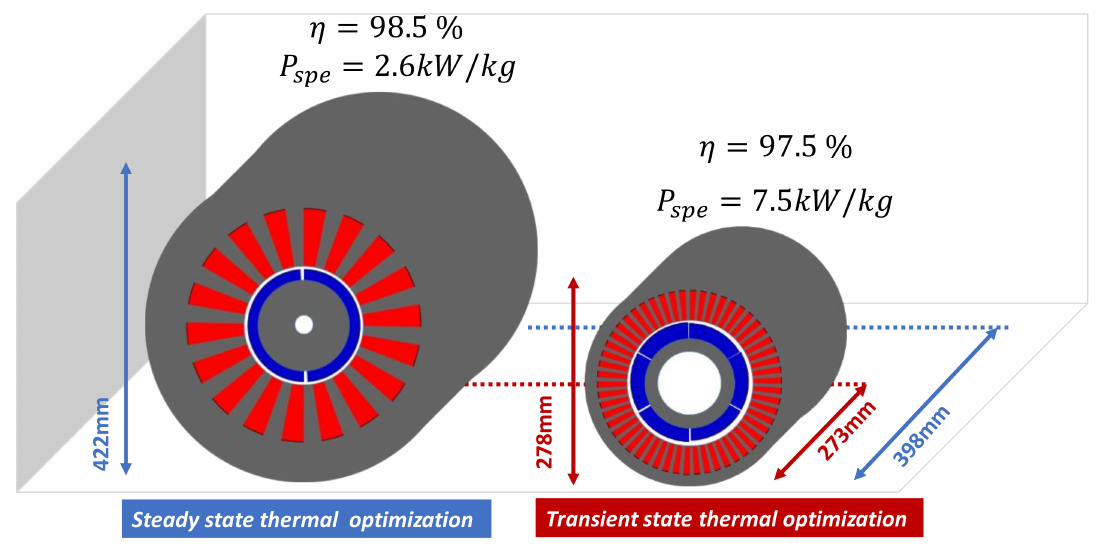
Figure 12. Cross-section of the electric motor optimization: left —steady-state thermal model, right —transient thermal model.